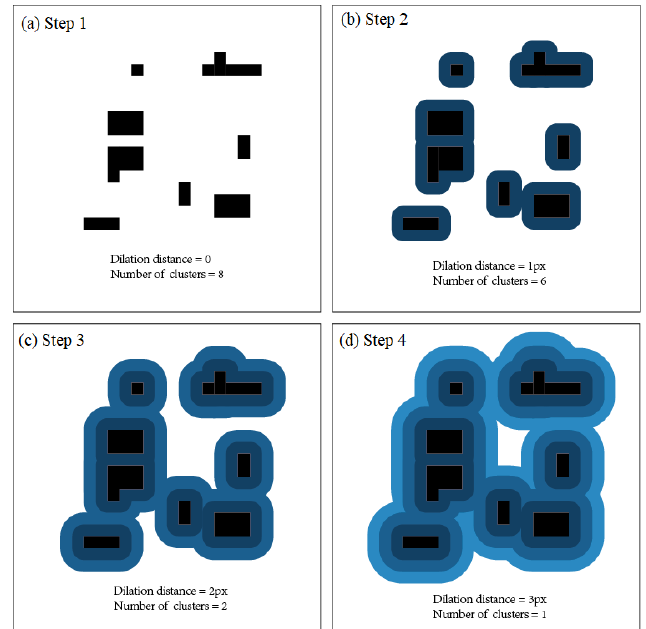
Figure 3. Minkowski dilation process.